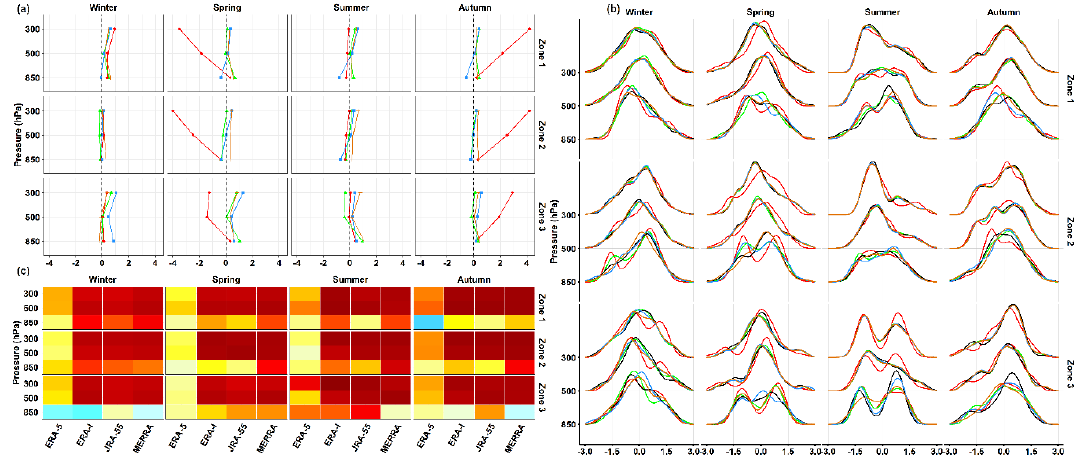
Figure 10. As in Figure 7, but for u-wind (m/s).